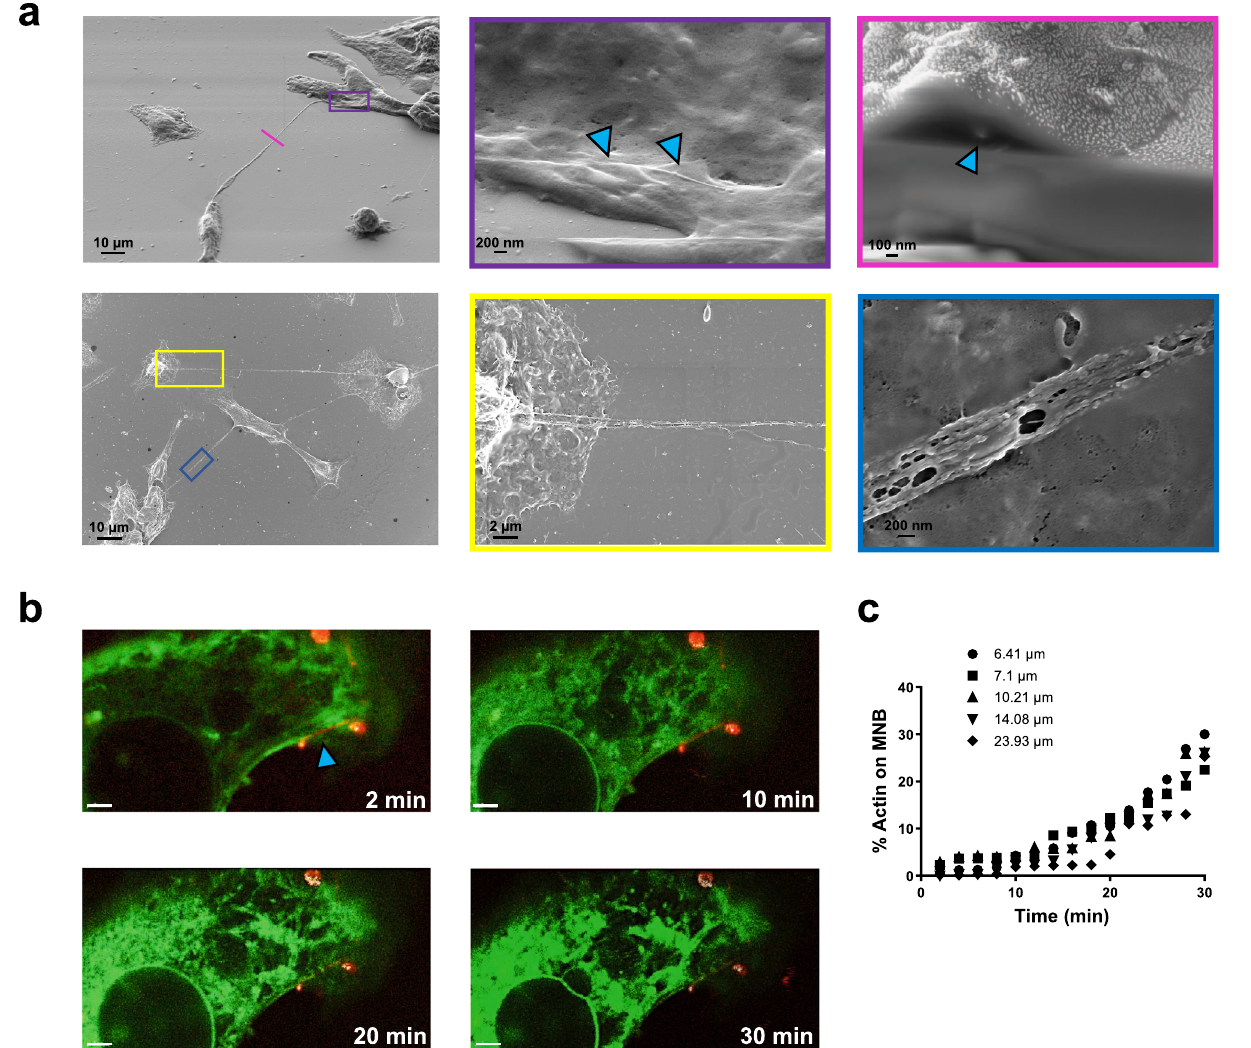
Fig. 3 Interaction of SiC-NWs with membranes in HL1 cells. a Top Left. SEM image of NWs forming an MNB physically coupling two distant cells. Top Middle. A blow-up of the purple box in the left image, showing partial internalization of SiC-NWs (blue arrowheads). Top Right. A focused Ion Beam was used to cut the MNB at the pink line in the left image (blue arrowhead points to SiC-NW). Bottom Left. Same as a , showing multicellular synthetic coupling created by SiC-NWs. Bottom Middle. A blow-up of the yellow box in the left image, showing that several SiC-NWs can form branches connecting multiple cells. Bottom Right. A blow-up of the blue rectangle, showing that several NWs can form a single MNB( n = 5 experiments repeated with similar results). b Time-lapse recording of the biodynamic interface an HL1 cell live-stained for actin (green) and SiC-NW (red). Images were acquired every 2 min for a 30 min period; Scale bars: 2 µ m. Blue arrowhead indicates the position of the SiC-NW ( n = 17 biological independent cells). c MNB formation triggered by actin for SiC-NWs partial internalization ( n = 5). Legend numbers indicate SiC-NW lengths. Source data are provided as a Source Data fi